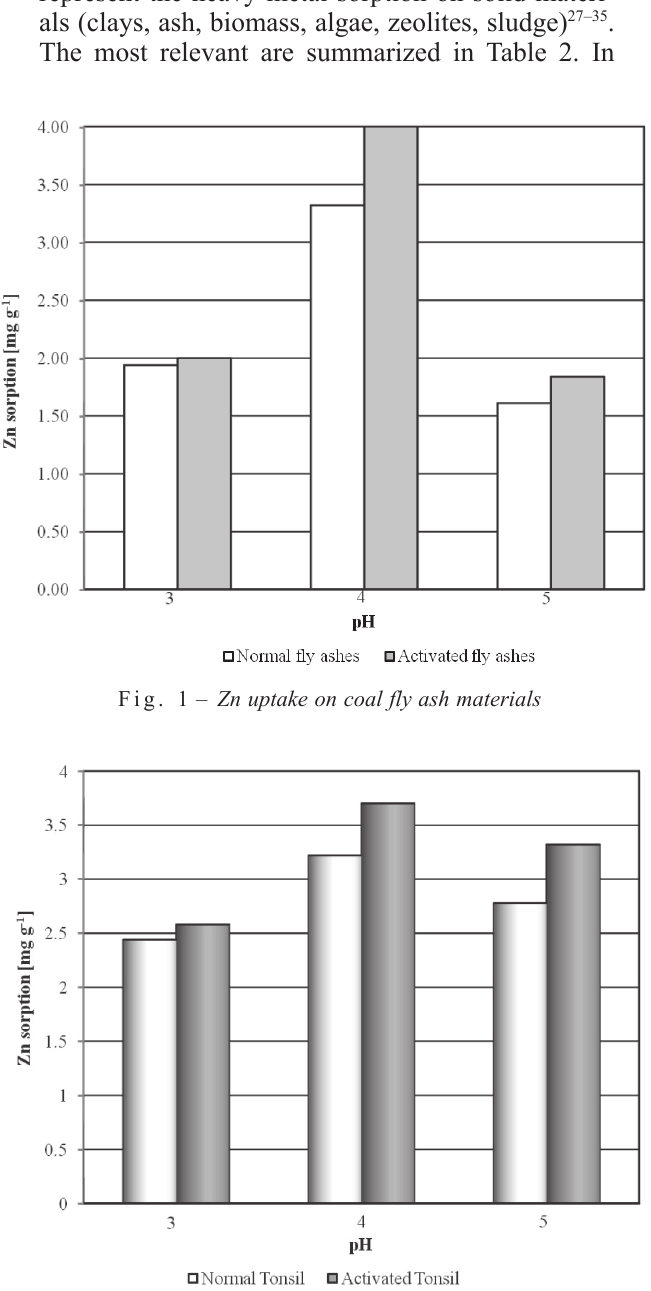
Fig. 2 – Zn uptake on Tonsil